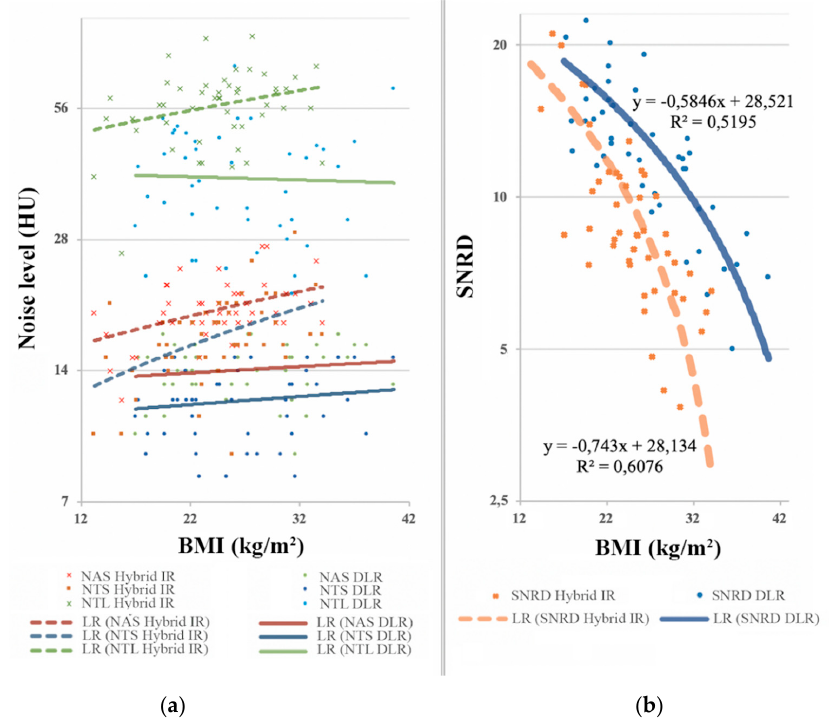
Figure 5. ( a ) Direct noise measurements based on BMI; ( b ) Evolution of signal-to-noise ratio per unit dose according to BMI. Across BMI categories, the image noise remained relatively stable on DLR images while steadily increasing on hybrid-IR images. The linear regression analysis of SNRD according to BMI revealed a slower decrease of SNRD on DLR images, in particular for overweight and obese patients. BMI, body mass index (kg / m 2 ); HU, Hounsfield units; SNRD, signal-to-noise ratio per unit dose; NAS, noise in the descending aorta on soft filter; NTS, noise in the trachea on soft filter; NTL, noise in the trachea on lung filter; LR, linear regression; Hybrid-IR, hybrid iterative reconstruction (AIDR 3D, adaptive iterative dose reduction 3-dimensional); DLR, deep learning reconstruction (AiCE, advanced intelligent clear-IQ